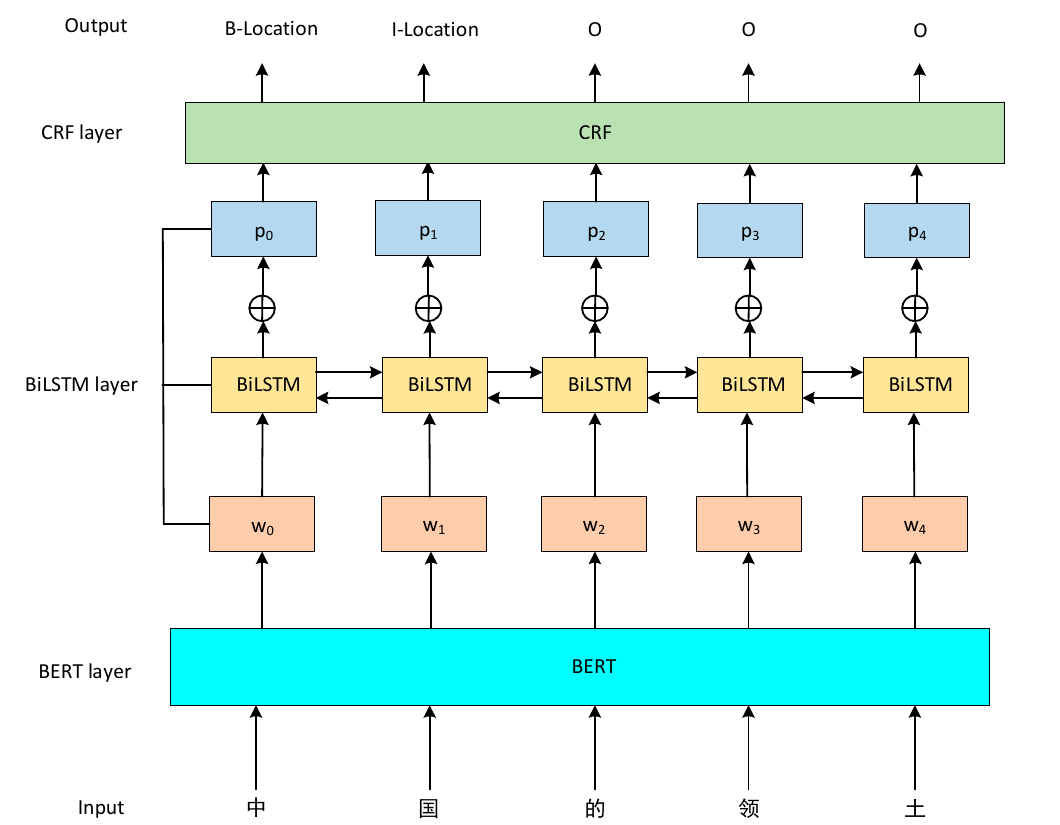
Figure 4. The structure of the BERT-BiLSTM-CRF model. The Chinese characters in the figure show the first to fifth characters of the territory of China expressed in Chinese.